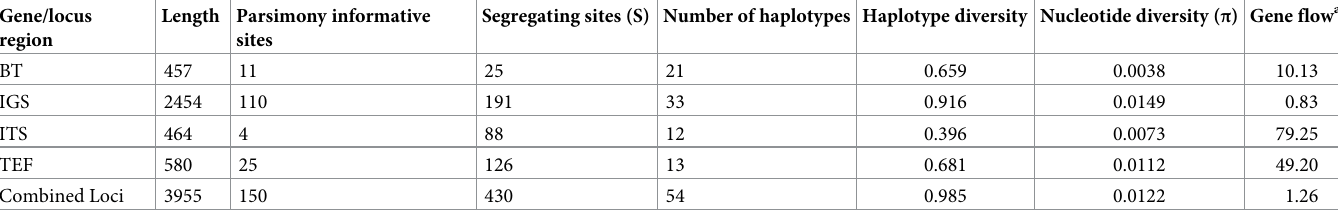
Table 3. Polymorphism statistics derived from multiple sequence alignments of different loci analyzed. Gene/locus Length Parsimony informative region